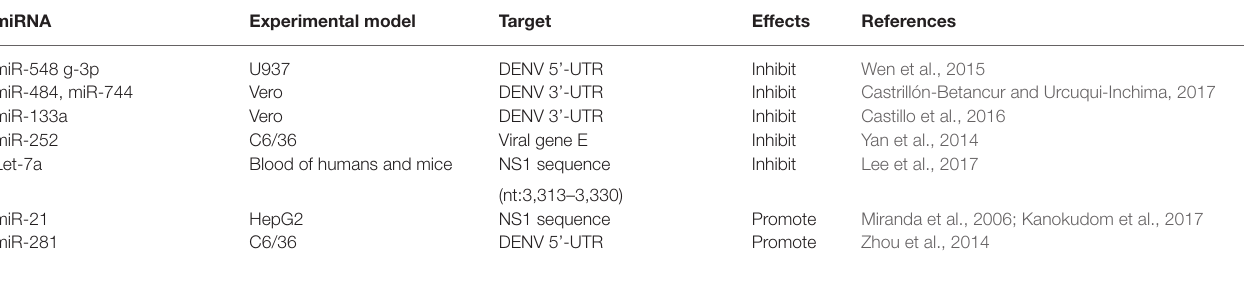
TABLE 1 | microRNAs that directly target viral genomes to inhibit or promote viral replication. miRNA Experimental